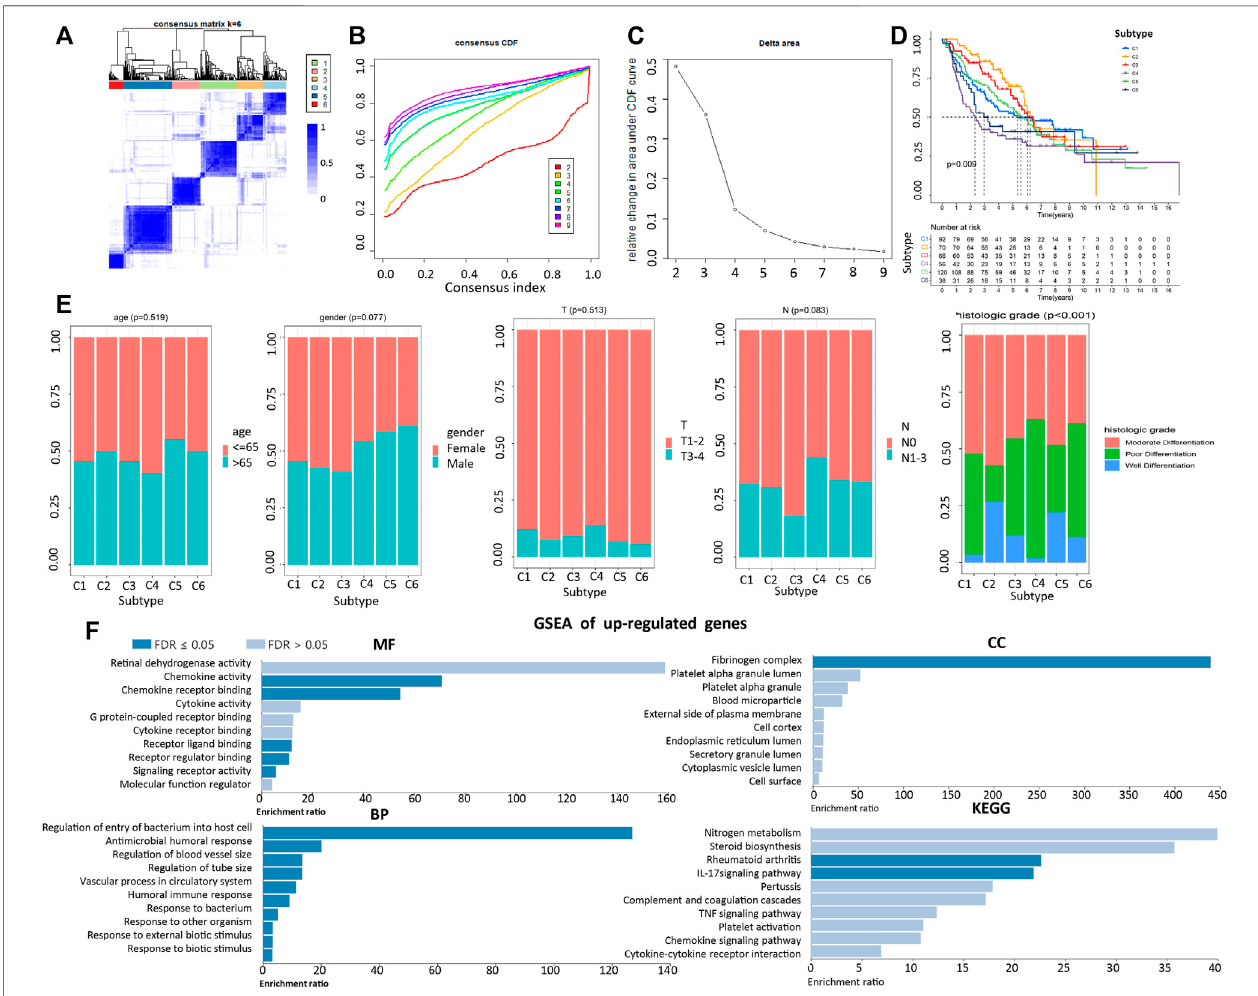
FIGURE 3 | Correlation of LUAD subtypes based on LDRGs with different OS and clinical characteristics. (A) Consensus clustering matrix of GEO cohort (k = 6). (B,C) CDFcurveofconsensusscore(k=2 – 9)inGEO cohort. (D) Kaplan-Meier survivalanalysisofthe6subtypesofLUADpatients intheGEO cohort. (E) Comparisons of the clinicopathological variables with six subtypes patients. (F) MF, CC, BP, and KEGG analysis of co-upregulated genes. An FDR < 0.05 was considered statistically signi fi cant.